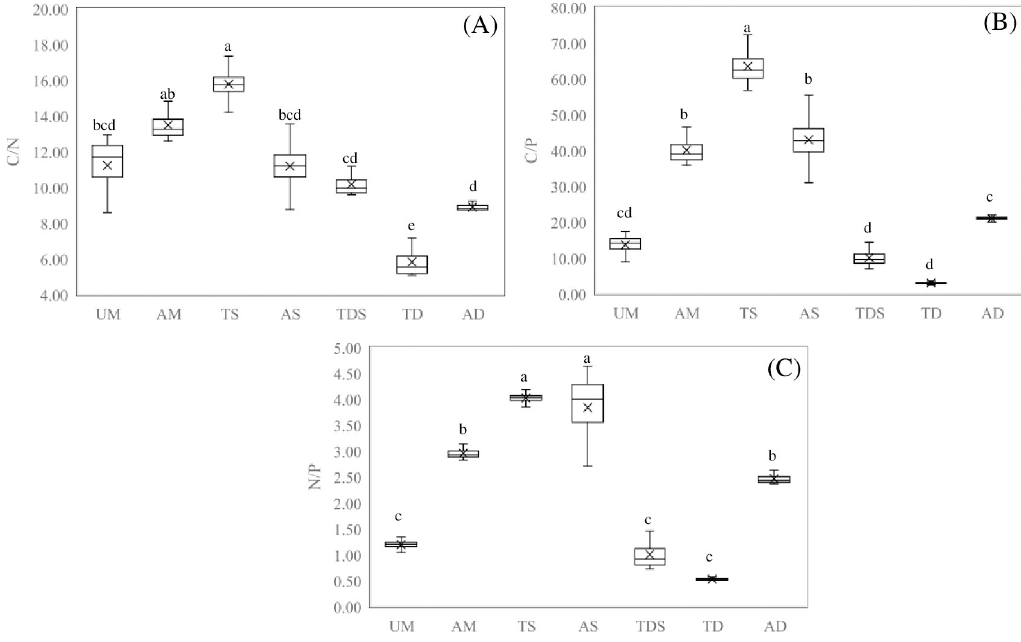
Fig 2. Stoichiometric ratio of C, N and P in different types grassland.